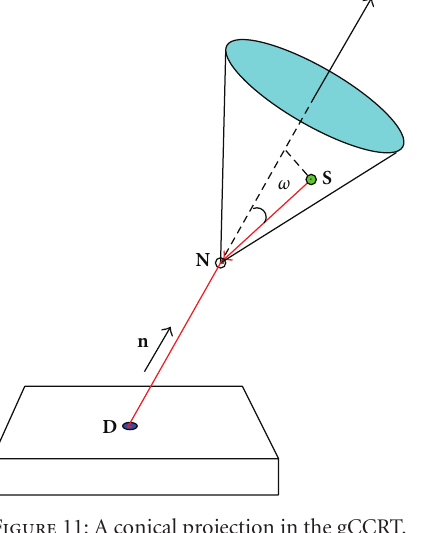
Figure 11: A conical projection in the gCCRT.